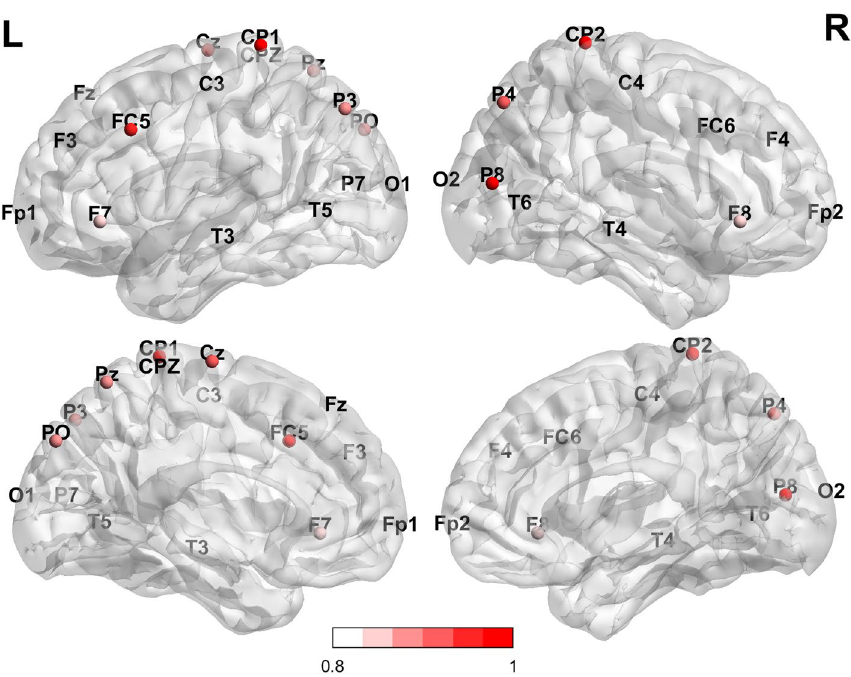
Figure 8. Loadings derives from PCA (Principal Component Analysis) for backward mental imagery. Two components which explained 94% of the total variance were reported. There was more beta synchronisation in parietal and fronto-parietal areas bilaterally and less beta synchronisation in frontal areas bilaterally and unilaterally left areas (Top: Sagittal external section; Bottom: internal sections. L: left hemisphere; R: right